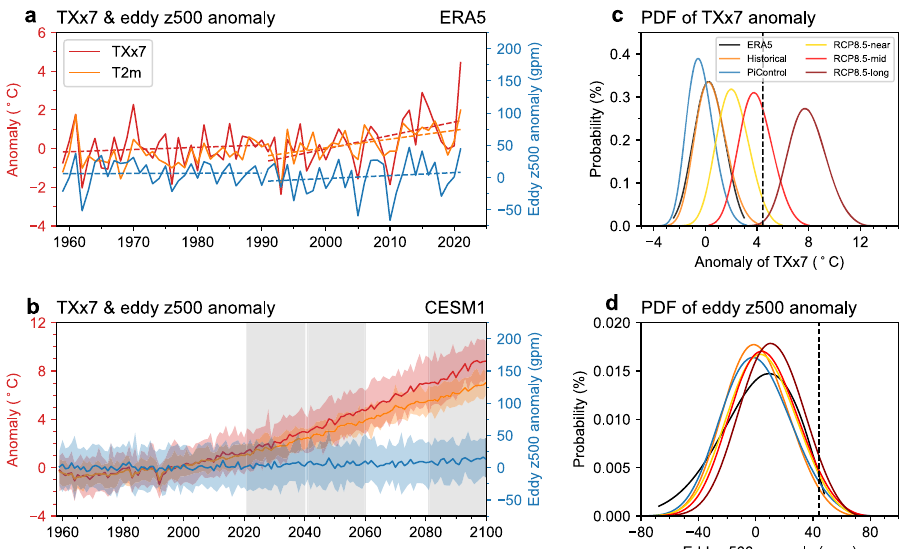
Fig. 3 | The time series and probability density function (PDF) distribution of TXx7 anomaliesandcorrespondingeddygeopotentialheightanomalies. Here, TXx7 is de fi ned as the annual summer (June-August) maxima of the 7-day running mean of the daily maximum temperature anomaly area-weighted averaged over WesternNorth America (WNA). a The anomalies of annualsummer TXx7 (red solid line, unit: °C) and corresponding eddy geopotential height anomalies (blue solid line,unit:gpm)at500hPaarea-weightedaveragedovertheWNAduring1959 – 2021 for ERA5 reanalysis. The orange line denotes the summer mean 2m mean tem- perature anomaly area-weighted averaged over the WNA. The dotted line denotes the trend of TXx7 anomalies and corresponding eddy geopotential height anomalies. b is the same as a but for the CESM1 historical and RCP8.5 simulations during1959 – 2100.Thegrayshadowsdenotethenear-term(2021 – 2040),mid-term